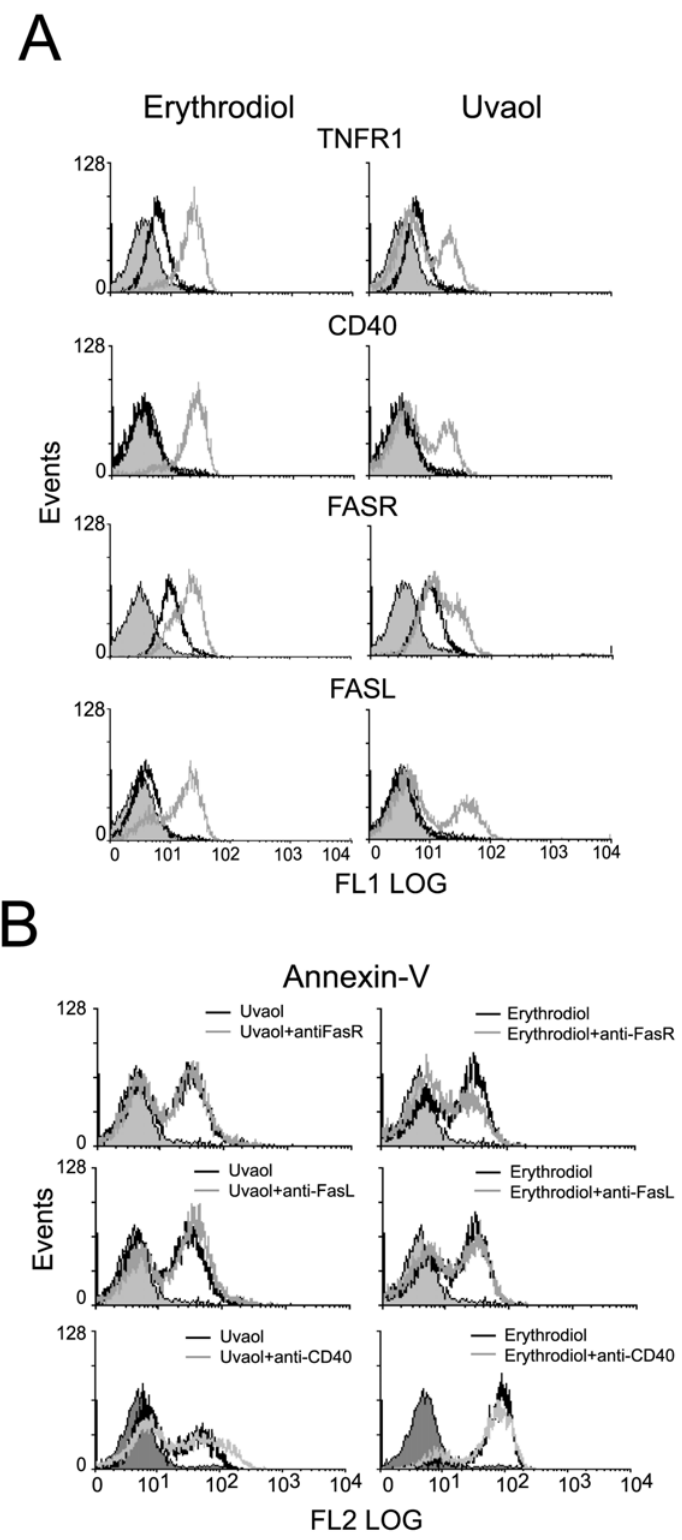
Figure 7. Effect of triterpenic diols on the expression and activity of death receptor/ligand systems. A, The expression of TNFR1, CD40, Fas and FasL was determined by flow cytometry, in 1321N1 cell exposed to 25 m M erythrodiol or 50 m M uvaol for 18 h. Histograms represent one experiment out of three. Solid gray curves represent unspecific binding; empty black curves, cells cultured in the absence of treatment (control); and empty gray curves, triterpene-treated cells. B, Cells were treated with 25 m M erythrodiol or 50 m M uvaol, in absence ( black empty curve) or presence ( grey empty curve) of anti-CD40, anti-Fas or anti FasL antibodies for 18 h. Afterward, the cells were labeled with annexin-V PE and analyzed by flow cytometry. doi:10.1371/journal.pone.0005975.g007 PLoS ONE |